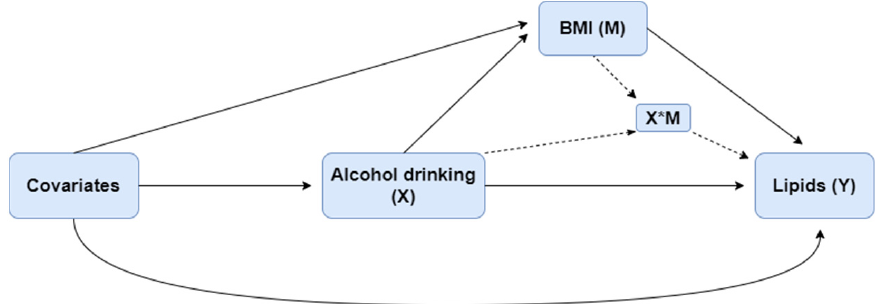
Figure 1. The relationship among alcohol consumption (X), BMI (M), and lipids (Y). The modification effect of drinking on the association between BMI and lipid-related biomarkers was confirmed by linear regression models with interactions. Further, we detect the effect of BMI on lipid parameters at different drinking status using linear regression models. Age, energy intake, region, and education were adjusted as covariates in four-way decomposition and regression models. Statistical analyses were implemented with R for windows (v. 3.6.3, http://www.r-project.org/ (accessed on 25 November 2021)) and SAS version 9.4 (SAS Institute, Cary, NC, USA). Table 1 summarizes descriptive characteristics of study variables by drinking status. Continuous variables were compared between drinkers and non-drinkers, adjusting for age (except age itself). The mean levels of alcohol consumption, TC, TG, APO-A, APO-B, and energy intake were significantly higher in drinkers, while non-drinkers had higher LDL-C. In total, 77.7% of non-drinkers have never drunk, while over a half of drinkers drink every day. In addition, the proportion of males was higher among drinkers than among non-drinkers; the distribution of educational level had significant group differences. Table 1. Descriptive data of study variables by alcohol